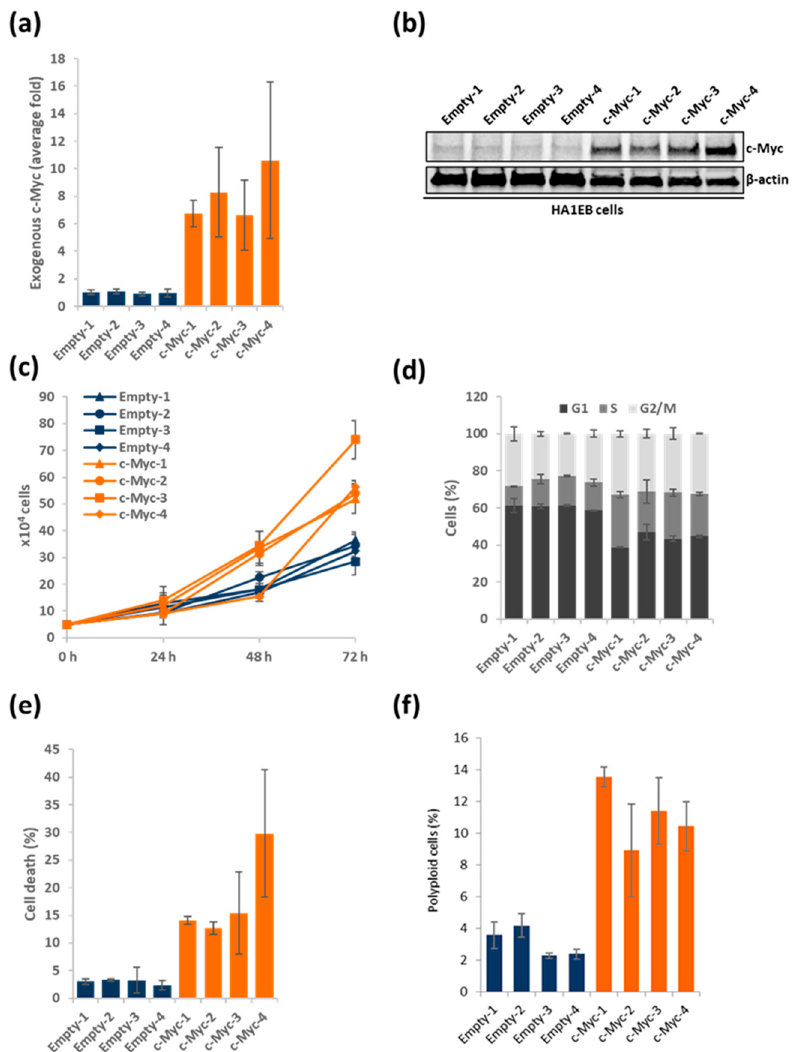
Figure 1. HA1EB cells overexpressing c-Myc proliferate faster. ( a ) Exogenous c-Myc mRNA levels in HA1EB cells, n = 3 ± S.E.M. ( b ) Exogenous c-Myc protein expression in HA1EB cells. ( c ) HA1EB cells were seeded and counted daily, n = 2 ± S.E.M. ( d ) Cell cycle profiles of HA1EB cells, n = 2 ± S.E.M. ( e , f ) HA1EB cells were seeded and left to grow for 72 h. Then, cells were harvested, stained with 7-AAD and analyzed using FACS. Dead cells ( e ), <2N DNA content and polyploid cells ( f ), >4N DNA content, n = 2 ± S.E.M.